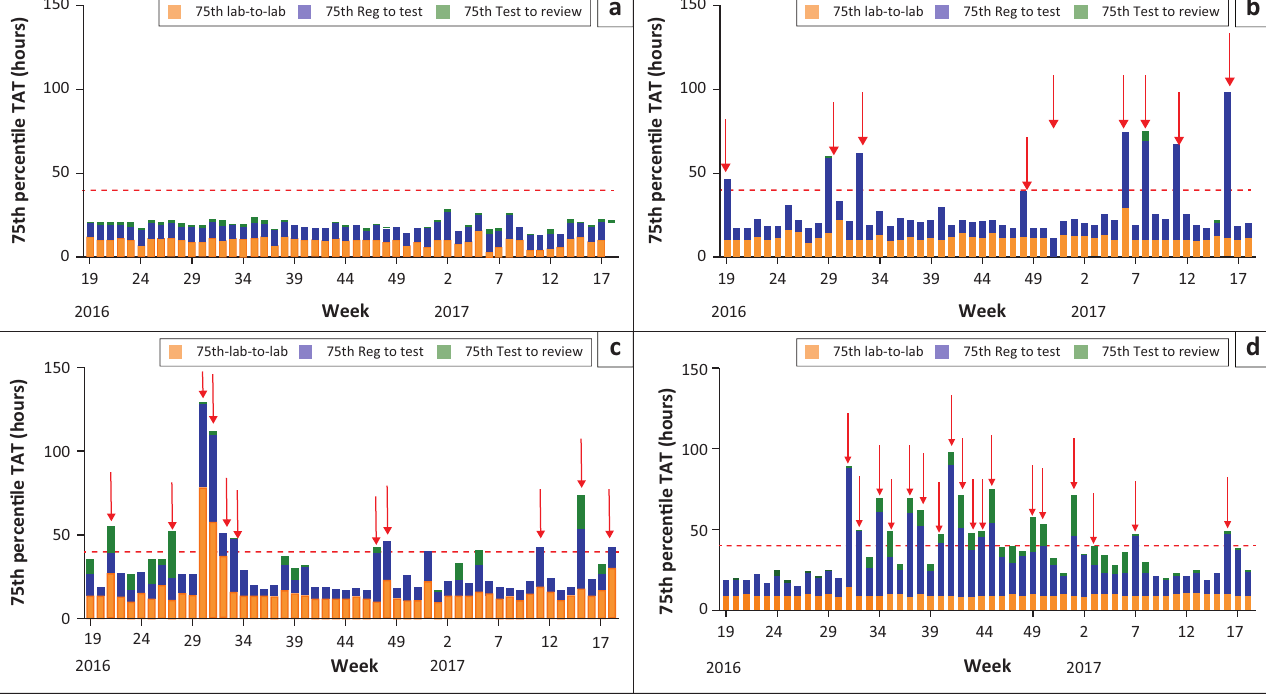
FIGURE 4: Stacked bar graphs showing examples of individual laboratory weekly performance for 2016/2017 financial year. 75th percentile turn-around time components color-coded: lab-to-lab (orange), reg-to-test (blue) and test-to-review (green), with cut-off of 40 h (red dotted lines). (a) good performance (laboratory A); (b) satisfactory performance (laboratory B); (c) moderate to poor performance (laboratory C) and (d) markedly poor performance (laboratory D).